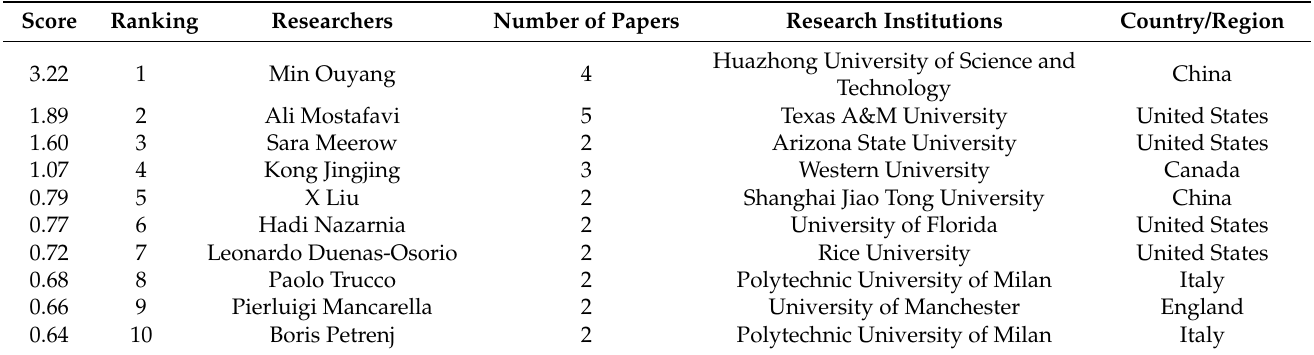
Table 3. Top 10 researchers involved in the research of IR.